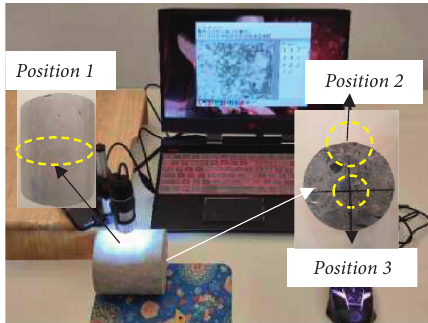
Figure 7: Microscopic observation.